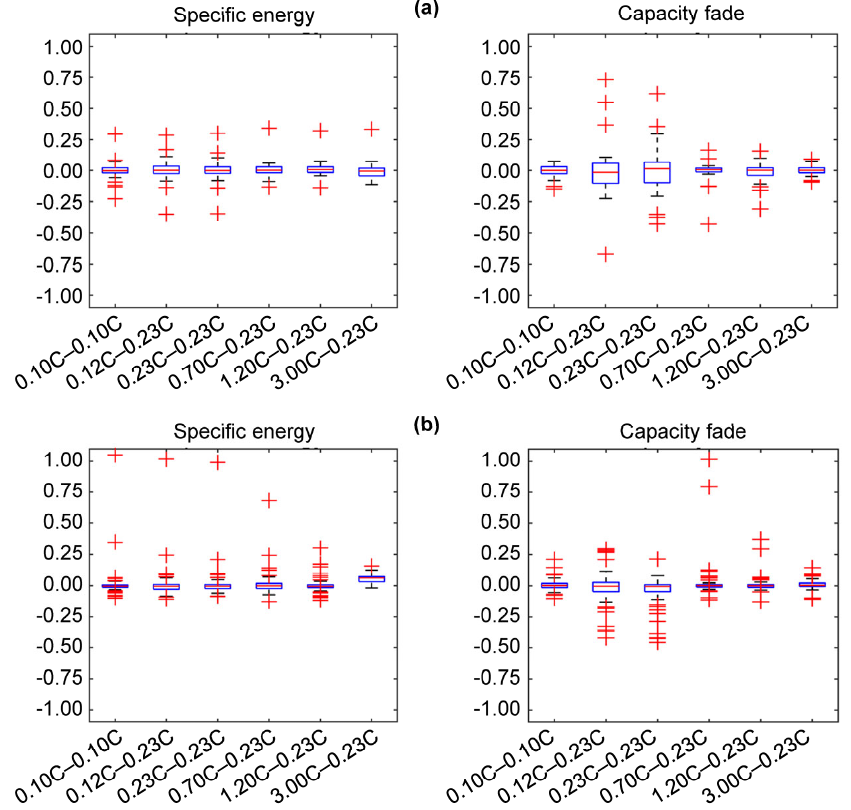
Figure 10. Performance of the GP regression models of the specific energy and capacity fade. ( a ) Box ‐ plots of the residuals of the GP models from leave ‐ one ‐ out cross ‐ validation. ( b ) Box ‐ plots of the residuals of the GP models using the 80 ‐ sample DOE as test data.